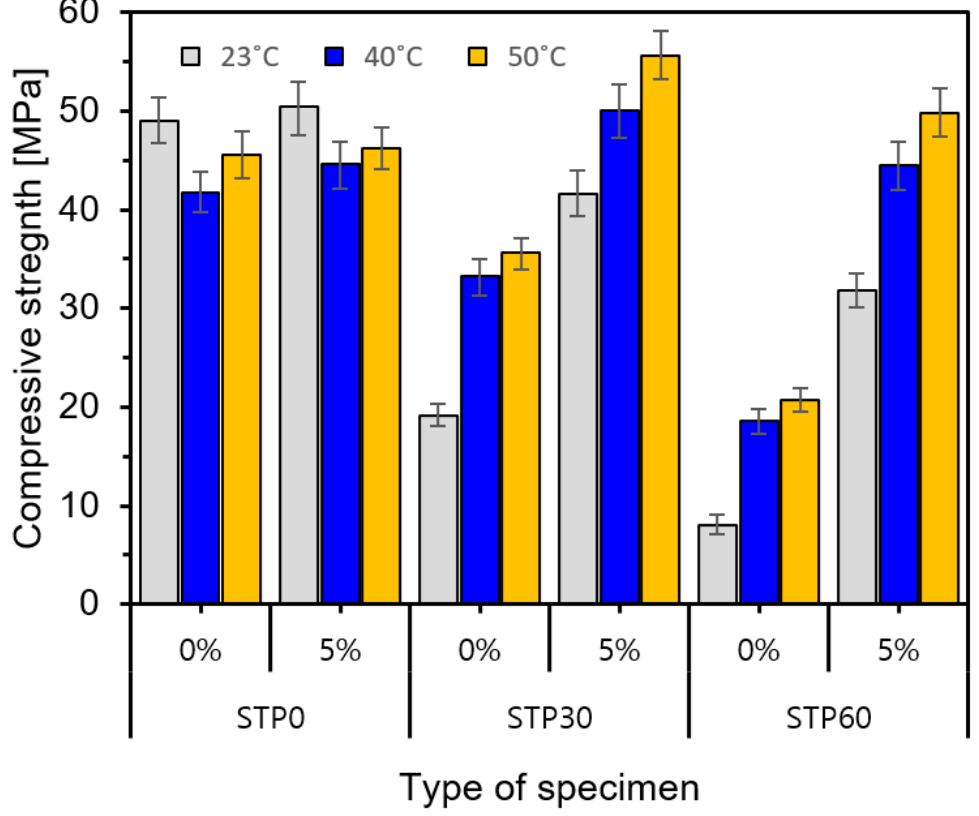
Figure 4. Compressive strength of specimens according to temperature.